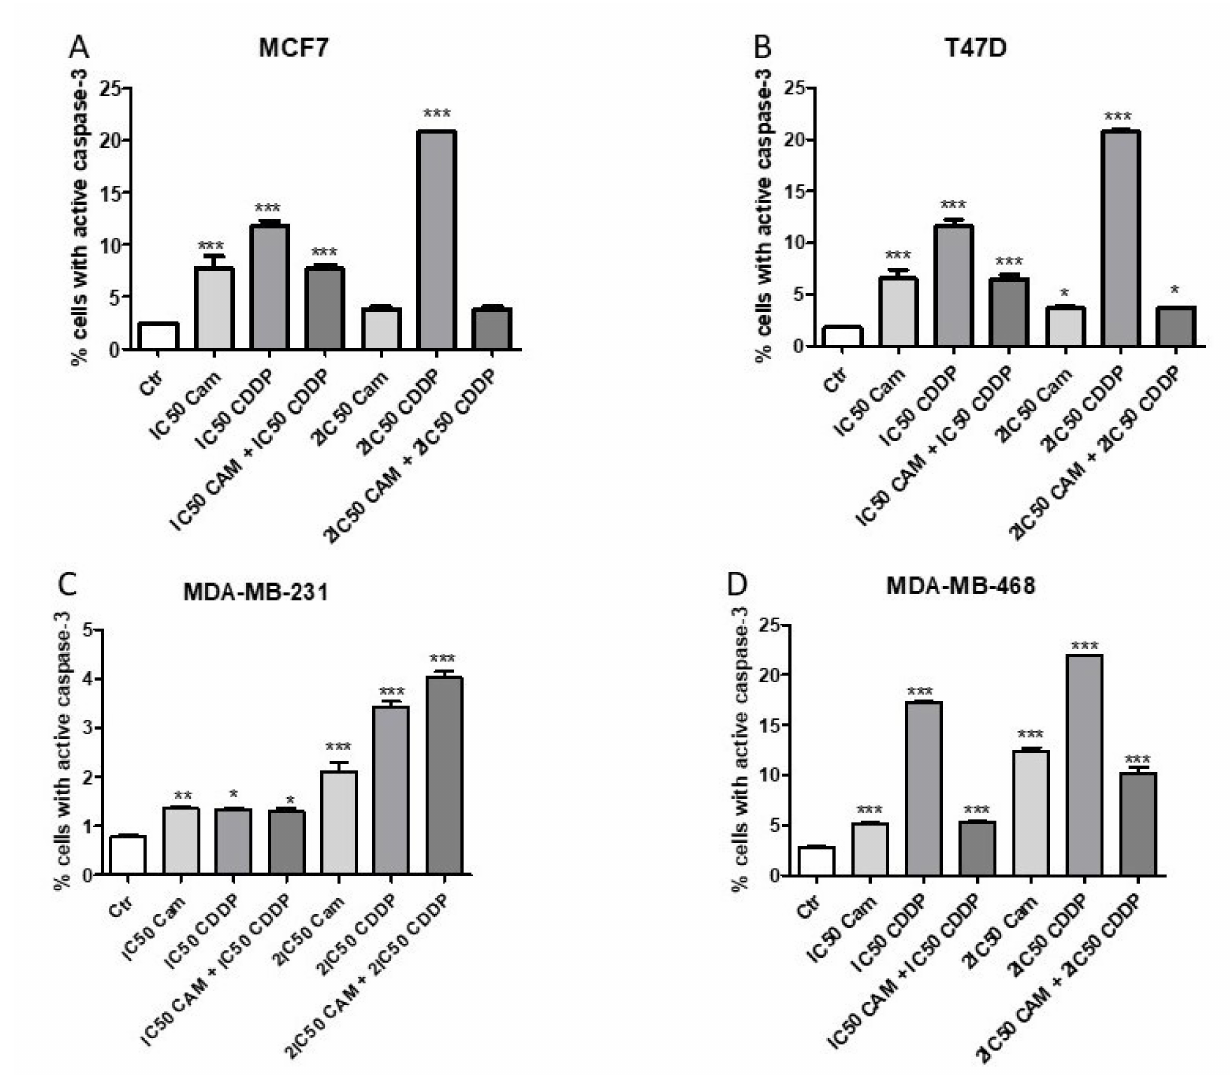
Figure 5. The effect of CAM and CDDP administered separately and in combination used in concentration of IC 50 and 2IC 50 for ( A ) MCF7, ( B ) T47D, ( C ) MDA-MB-231, and ( D ) MDA-MB-468 on cell lines on caspase-3 activation. All results were analyzed using GraphPad Prism 9.0 software (ordinary one-way ANOVA; Dunnett’s multiple comparisons test). Statistical differences were considered relevant at p < 0.05 (* p < 0.05, ** p < 0.01, *** p < 0.001 versus the control). Data are expressed as mean ± standard deviation of the mean ( ±